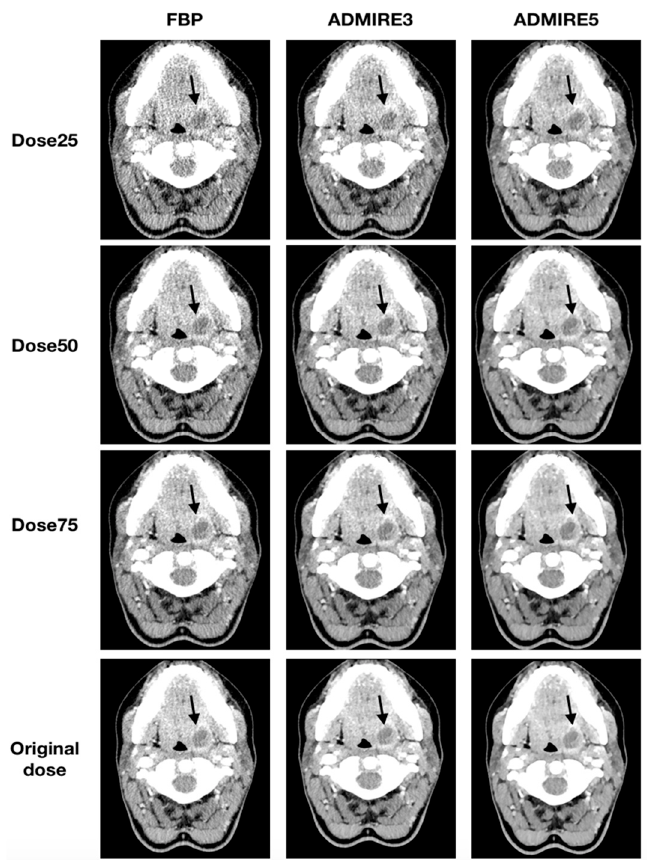
Figure 5. Axial tomographic slices of an 18 year old female patient with left-sided peritonsillar abscess (arrow). The images were reconstructed with FBP, ADMIRE 3, and ADMIRE 5 (from left to right) at 75%, 50%, and 25% dose reduction of the original dose.